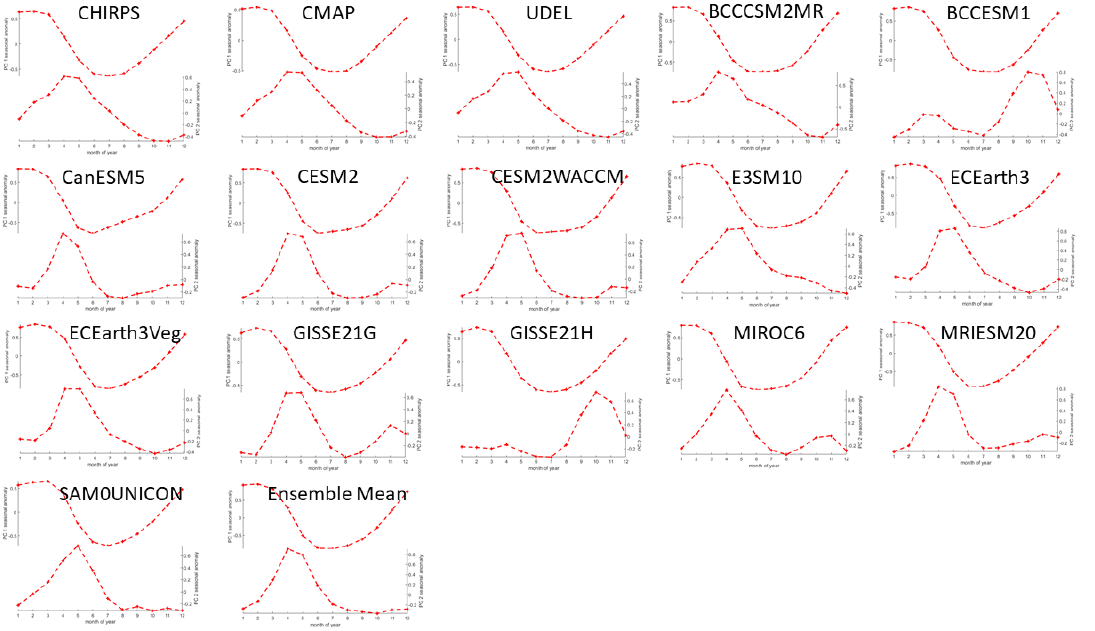
Figure 10. Principal component (PC) time series of first two modes for each dataset. First mode ( top panel for each observational dataset, model, and ensemble mean ranging from − 0.5 to 0.5) and second mode ( bottom panel ranging from − 0.4 to 0.8) show seasonal anomalies for each month of the year.